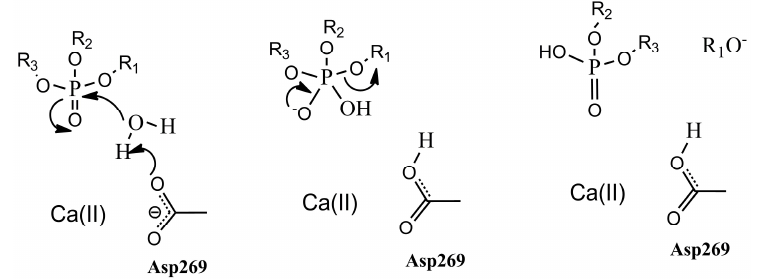
Figure 1. The reaction mechanism for PON1 and DFPase.